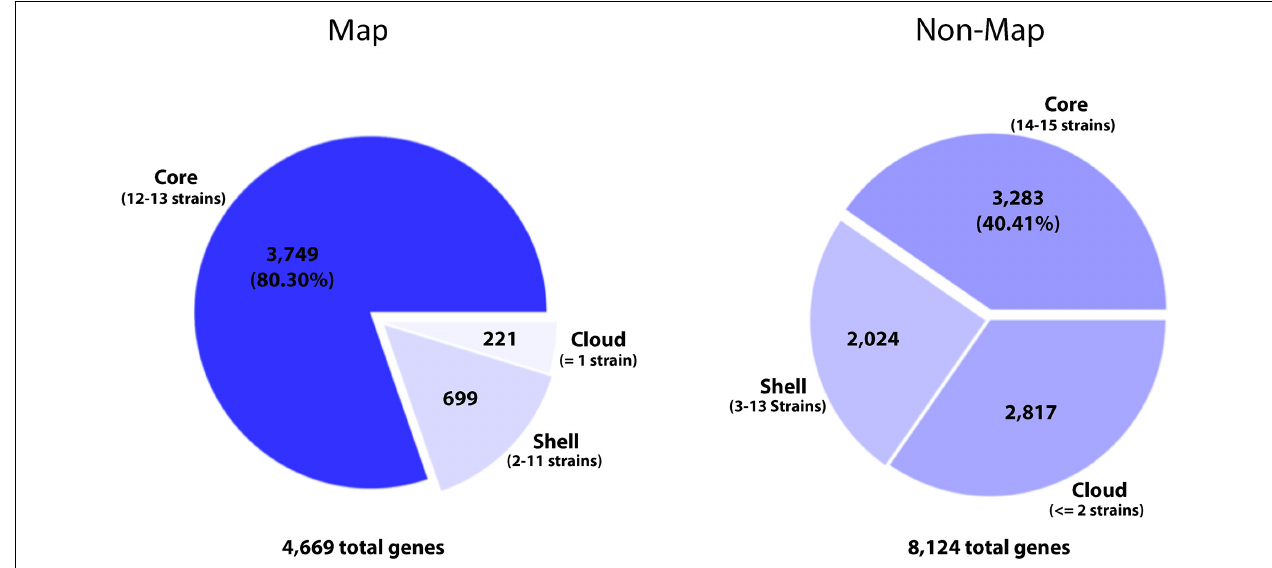
FIGURE 5 | Pie chart of the pangenomes for Map and non- Map strains. Beneath each chart are the total number of genes in the pangenome. The pangenome is subdivided into core and accessory genomes. The accessory genome is further subdivided into cloud and shell genomes, which are based on the number of genomes that contain the gene(s). Also shown are the number of genes present in each category. The darker the shade of blue on the chart, the higher percentage of genes present in that category. The number of strains necessary for a gene to meet the defined category is shown in